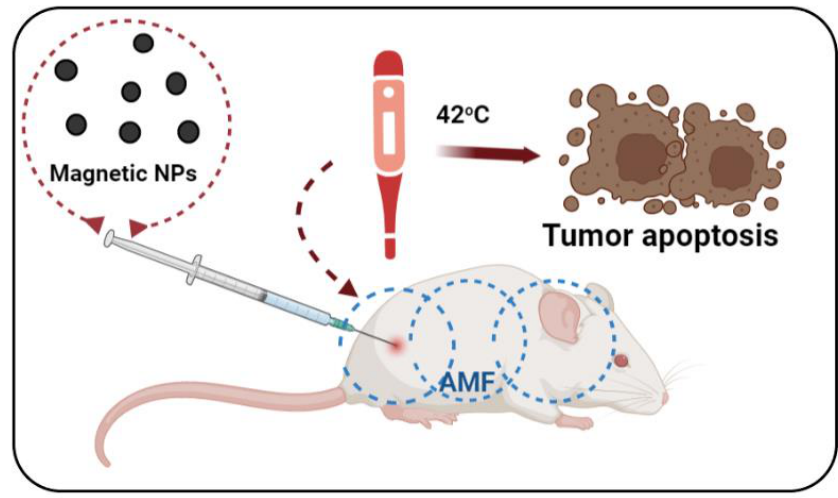
Figure 2. Schematic illustration for the MNPs-mediated MH working mechanisms under